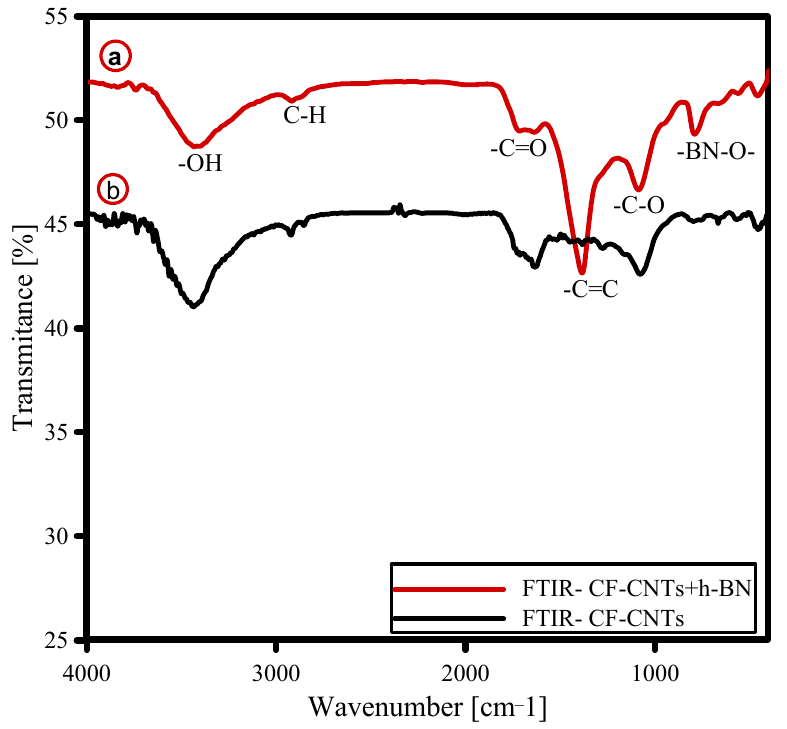
Figure 5. FTIR spectroscopy of (a) hBN/CF-CNTs; (b) CF-CNTs. UV–vis spectrophotometry was performed to analyze the nanoparticle dispersion in water, which is commonly associated with the homogeneity of the suspension for absorbance. According to Beer–Lambert’s law, the absorbance property of a solution im- mediately corresponds to the weight concentration of the absorbing form, for example, the concentration of nanoparticles in a solution. Based on Figure 6a, UV–vis of differ- ent hBN/CF-CNTs hybrid nanofluid system ratios recorded a sharp peak at 220 nm, indicating the appearance of CF-CNTs and hBN nanoparticles. Figure 6b,c present the details of nanoparticle size distribution and zeta potential for hBN@CF-MWCNTs after 20 days; hBN/CF-CNTs recorded a high zeta potential ( − 26.2 mV) 20 days after preparation. Water-based hBN/CF-CNTs hybrid nanofluids presented diffident zeta potential values for 20 days, respectively. Thus, it is concluded that water-based hBN/CF-CNTs nanofluids at 0.1 wt.% are suitable via the presence of additional stably eminent nanofluids relative to other hybrid nanofluids. The common size distribution for water-based hBN/CF-CNTs hy- brid nanofluids at 0.05 wt.% was additional land sliding compared with the same view for 0.1 wt.%. The nanoparticle size dispersal for water-based hBN/CF-CNTs hybrid nanofluids at 0.05 wt.% was 1882 nm after 20 days. However, the synthesis of nanofluids at 0.1